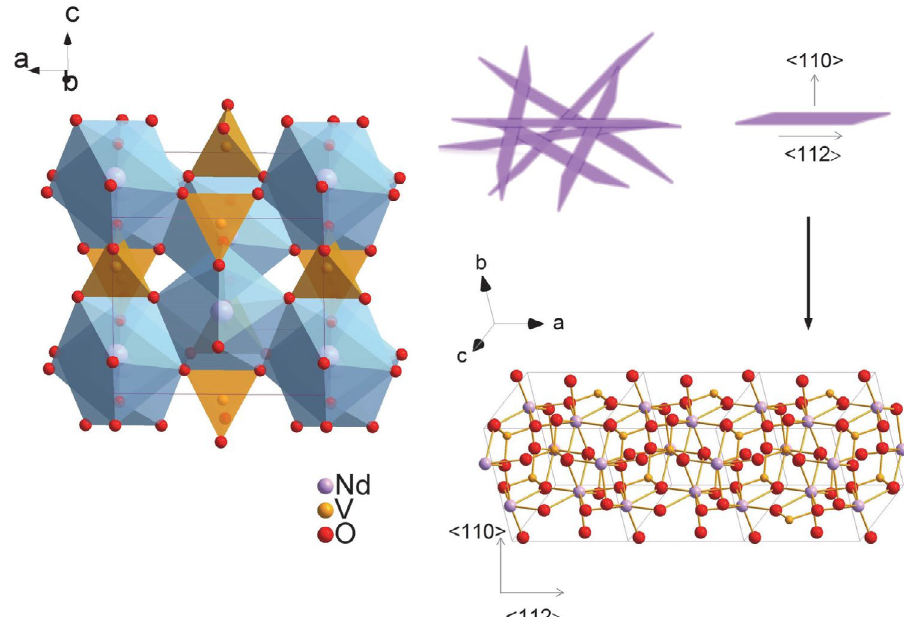
Fig. 4. (a) Crystal structure of NdVO 4 ; (b) Schematic representation of the as-grown NdVO 4 nanoneedles; (c) Ball-and-stick model showing a tetrag- onal NdVO